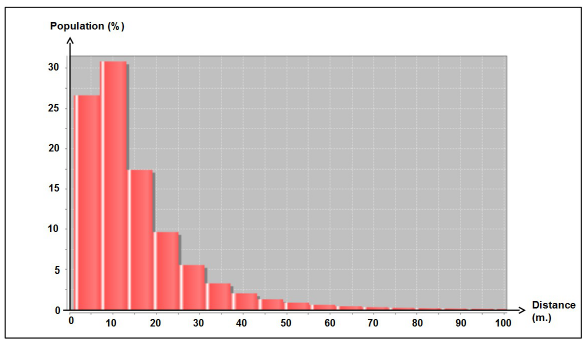
Figure 4. Distribution of inter-vertices distances extracted from the BDTOPO road network of